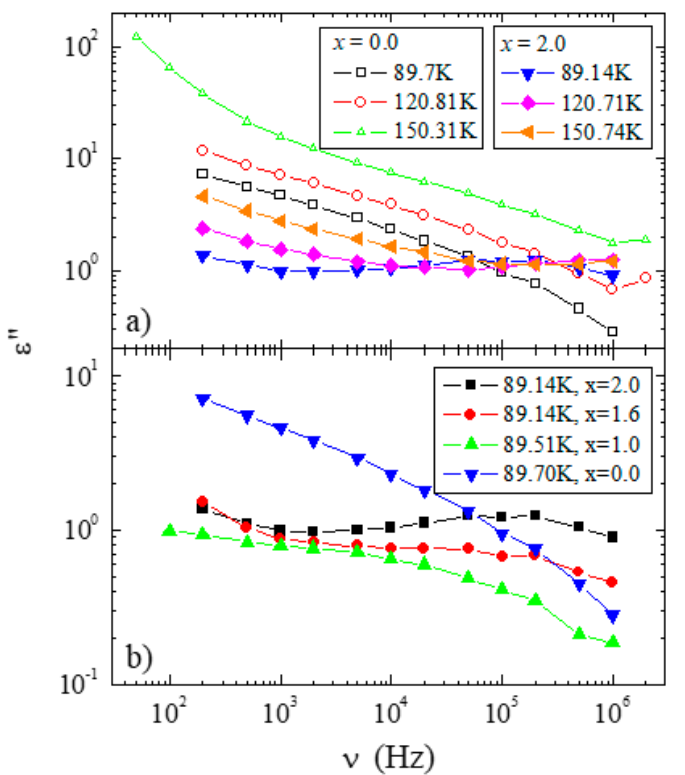
Figure 10. ( a ) A comparison of the dielectric loss spectra collected for the same temperatures and samples for x = 0.0 (empty symbols) and x = 2.0 (full symbols). ( b ) A comparison of the loss spectra for different samples at ≈ 89 K.